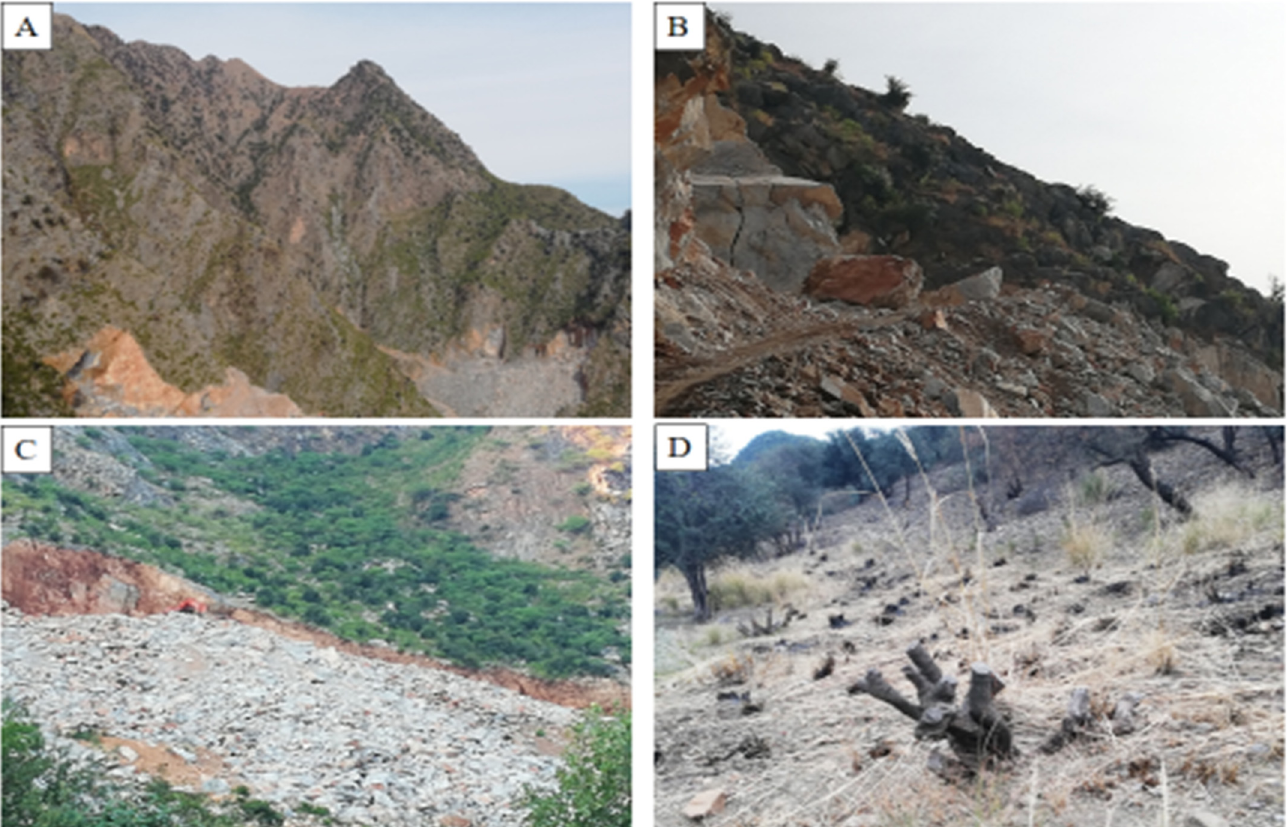
Figure 7. Disturbances in Monotheca forests: ( A ) marble extraction in district Buner, ( B ) making of roads in Khyber District, ( C ) land use change in Sherani District, ( D ) Cutting in Nowshehra District.